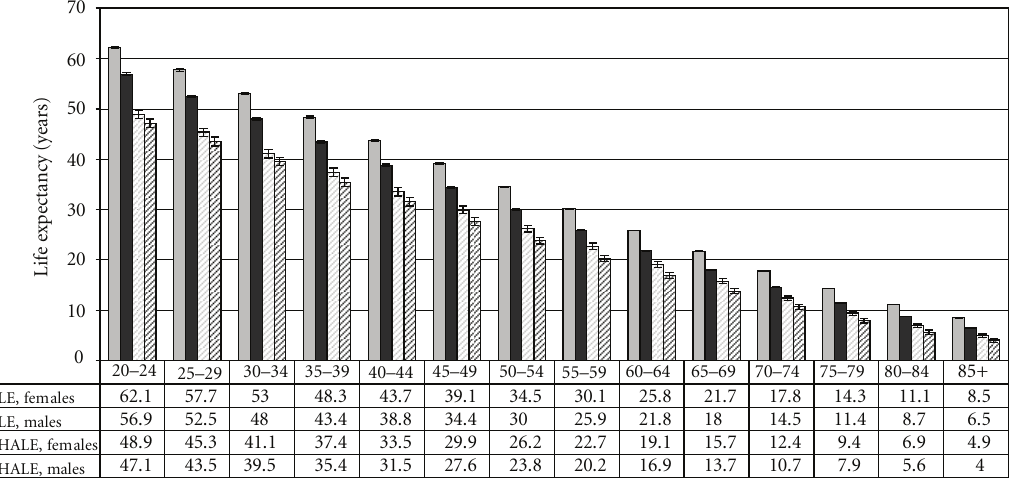
Figure 2: Life expectancy (LE) and health adjusted life expectancy (HALE) for females and males, with hypertension, Canada, 2004 to 2006. (Data source: Canadian community health survey data files (CCHS) from Statistics Canada, 2000–2005 and Canadian Chronic Disease Surveillance System Data Files (CCDSS) from Public Health Agency of Canada, 2004–2006. Data Files excluded Quebec, Nunavut and Northwest